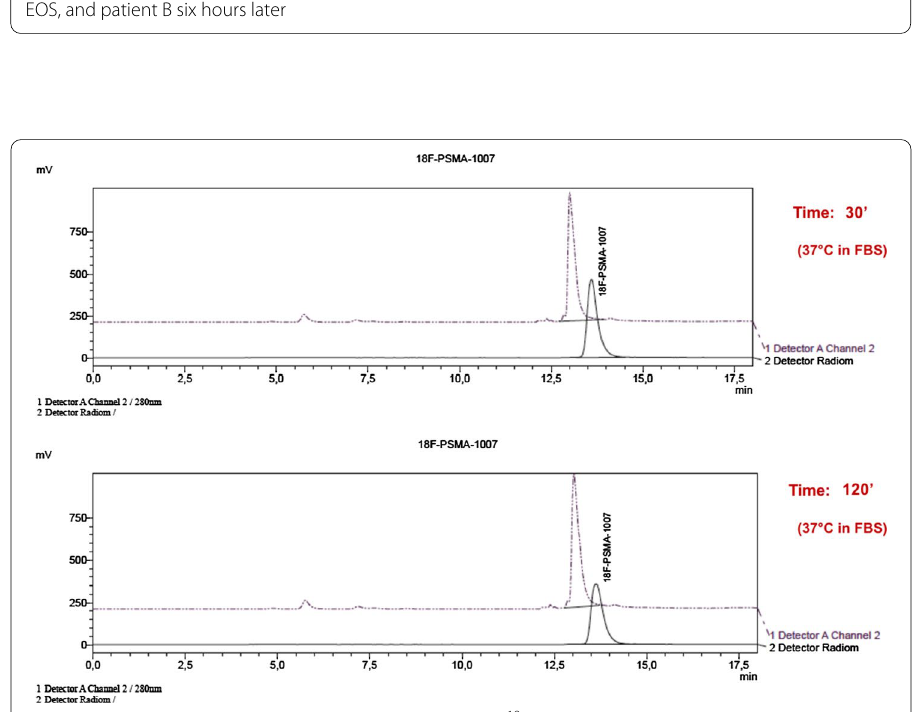
Fig. 3 Studies of stability were performed by incubating of [ 18 F]PSMA-1007 at 37 °C in FBS at the concentration of 37 MBq/mL. The chromatograms confirm the stability of the radiolabeled compound up to 120